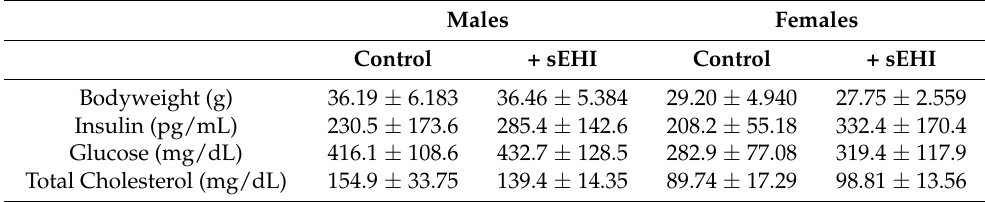
Table 1. Bodyweight and serum